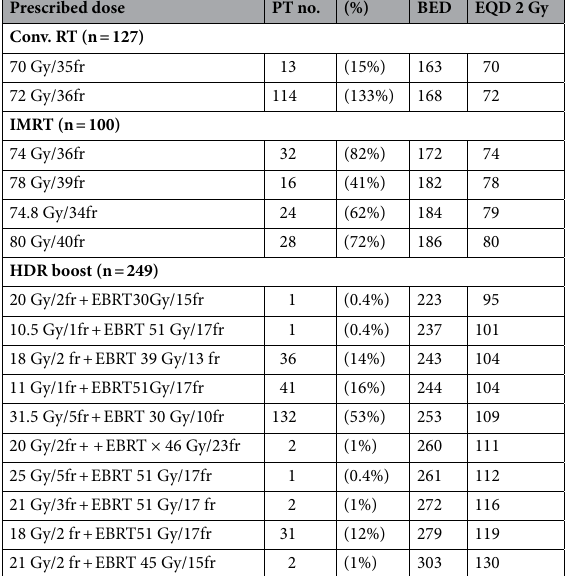
Table 2. Detailed schedule of radiotehrapy and BED or EQD2 for each treatment. EQD 2 Gy = n × d × (α/β + d)/(α/β + 2) (α/β = 1.5 Gy, n = fraction number, d = single dose). BED = n × d × (1 + d/(α/β)); (α/β = 1.5 Gy, n = fraction number, d = single